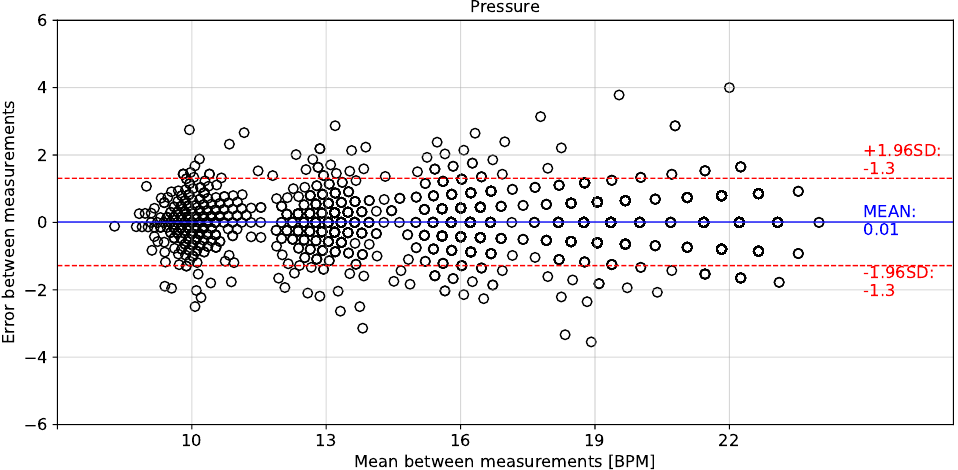
Figure 15. Bland–Altman plot for instantaneous breathing rate using pressure signal compared to airflow